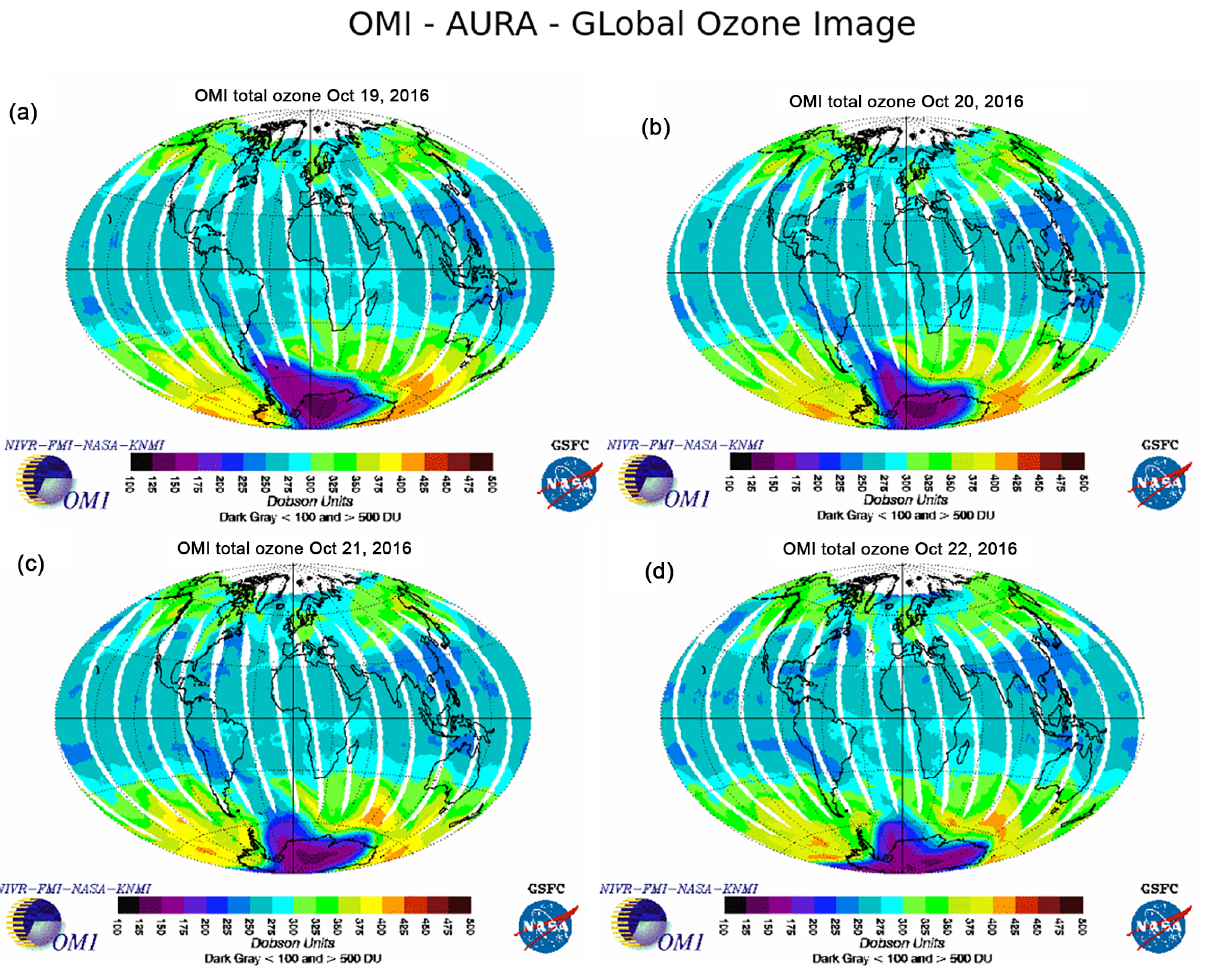
Figure 6. Time evolution of the total ozone column as observed by the OMI-ERS2 satellite from 19 to 22 October 2016. Available at OMI (2018). The effect of the ozone hole over South America, especially over Uruguay and southern Brazil, which is the region highlighted in the light blue